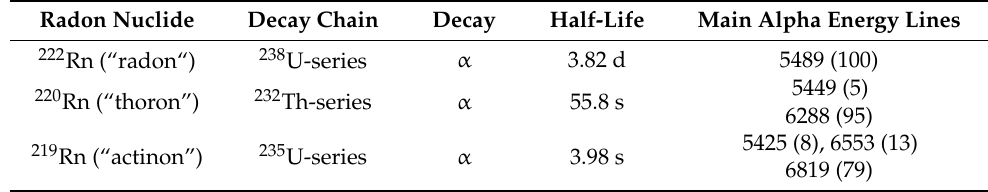
Table 5. Properties of radon nuclides. Alpha energy lines in keV with emission probability in %. All data from